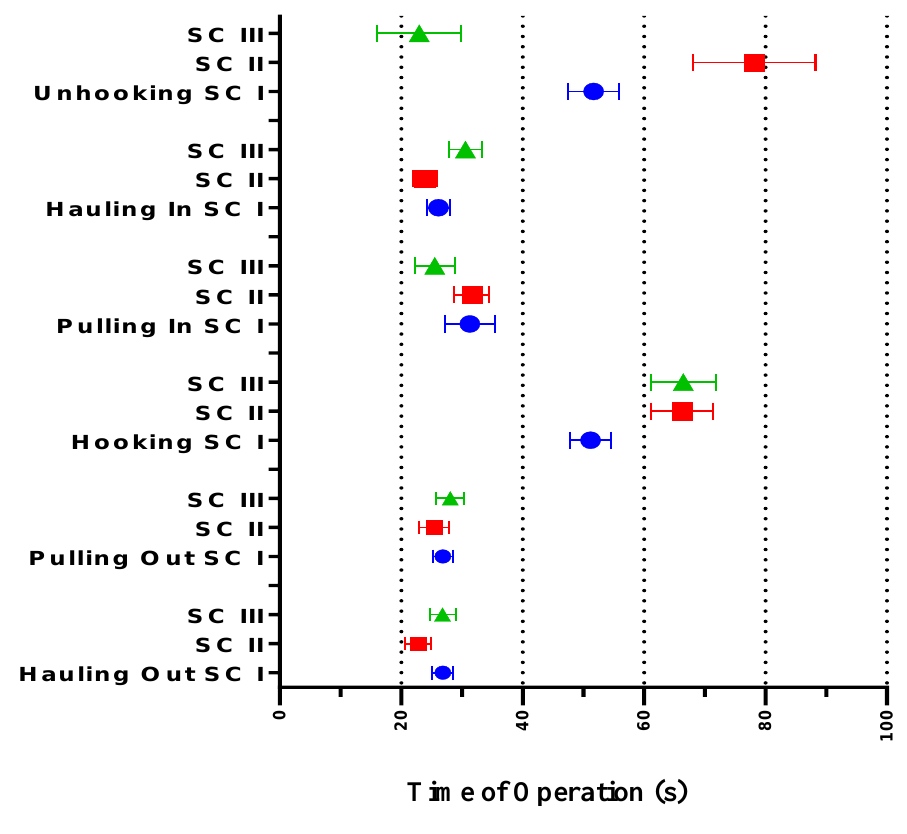
Figure 9. Breakdown of individual time operations for the each work element per cycle and standard error for each SC.